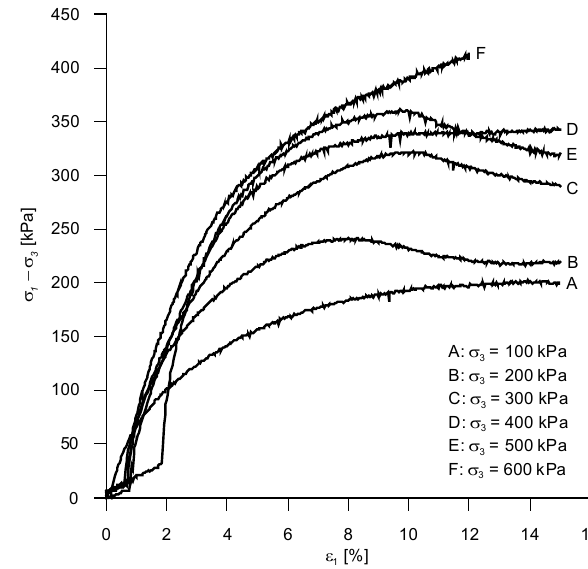
Figure 11: Illustration of the results of strength tests of soil of very stiff consistency (A-4 and B-4) from one sample.